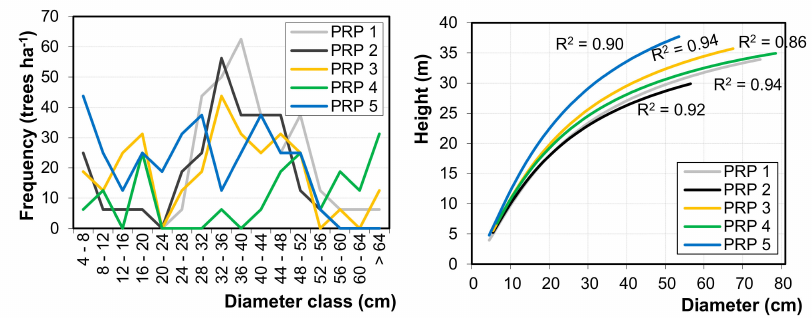
Figure 3. Frequency in each diameter class ( left ) and height curves produced with Näslund function ( right ) for Fagus orientalis Lipsky of each permanent research plot (PRP); R 2 indicates coe ffi cient of